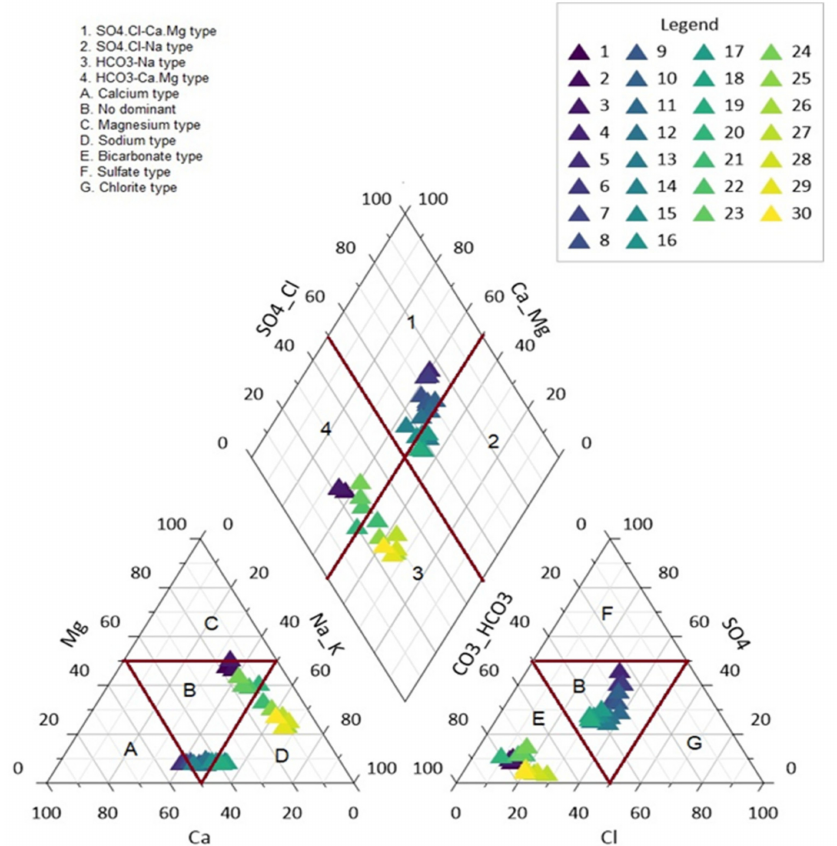
Figure 2. Relative ionic composition